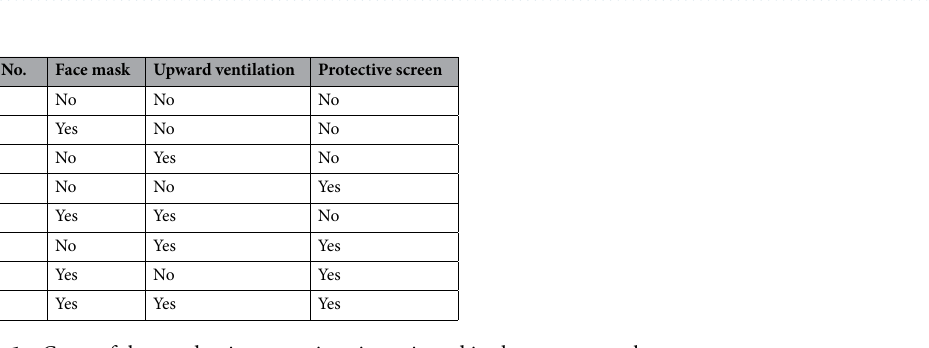
Table 1. Cases of the pandemic precautions investigated in the present work.